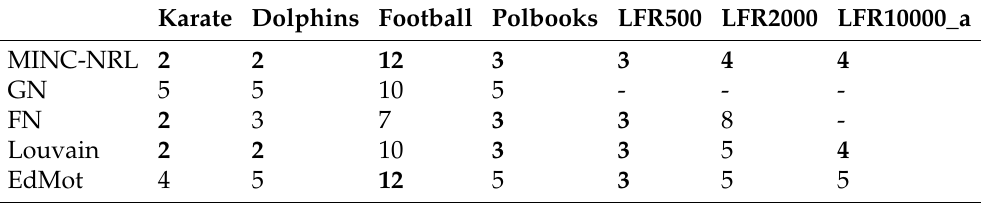
Table 4. CN of MINC-NRL compared with other